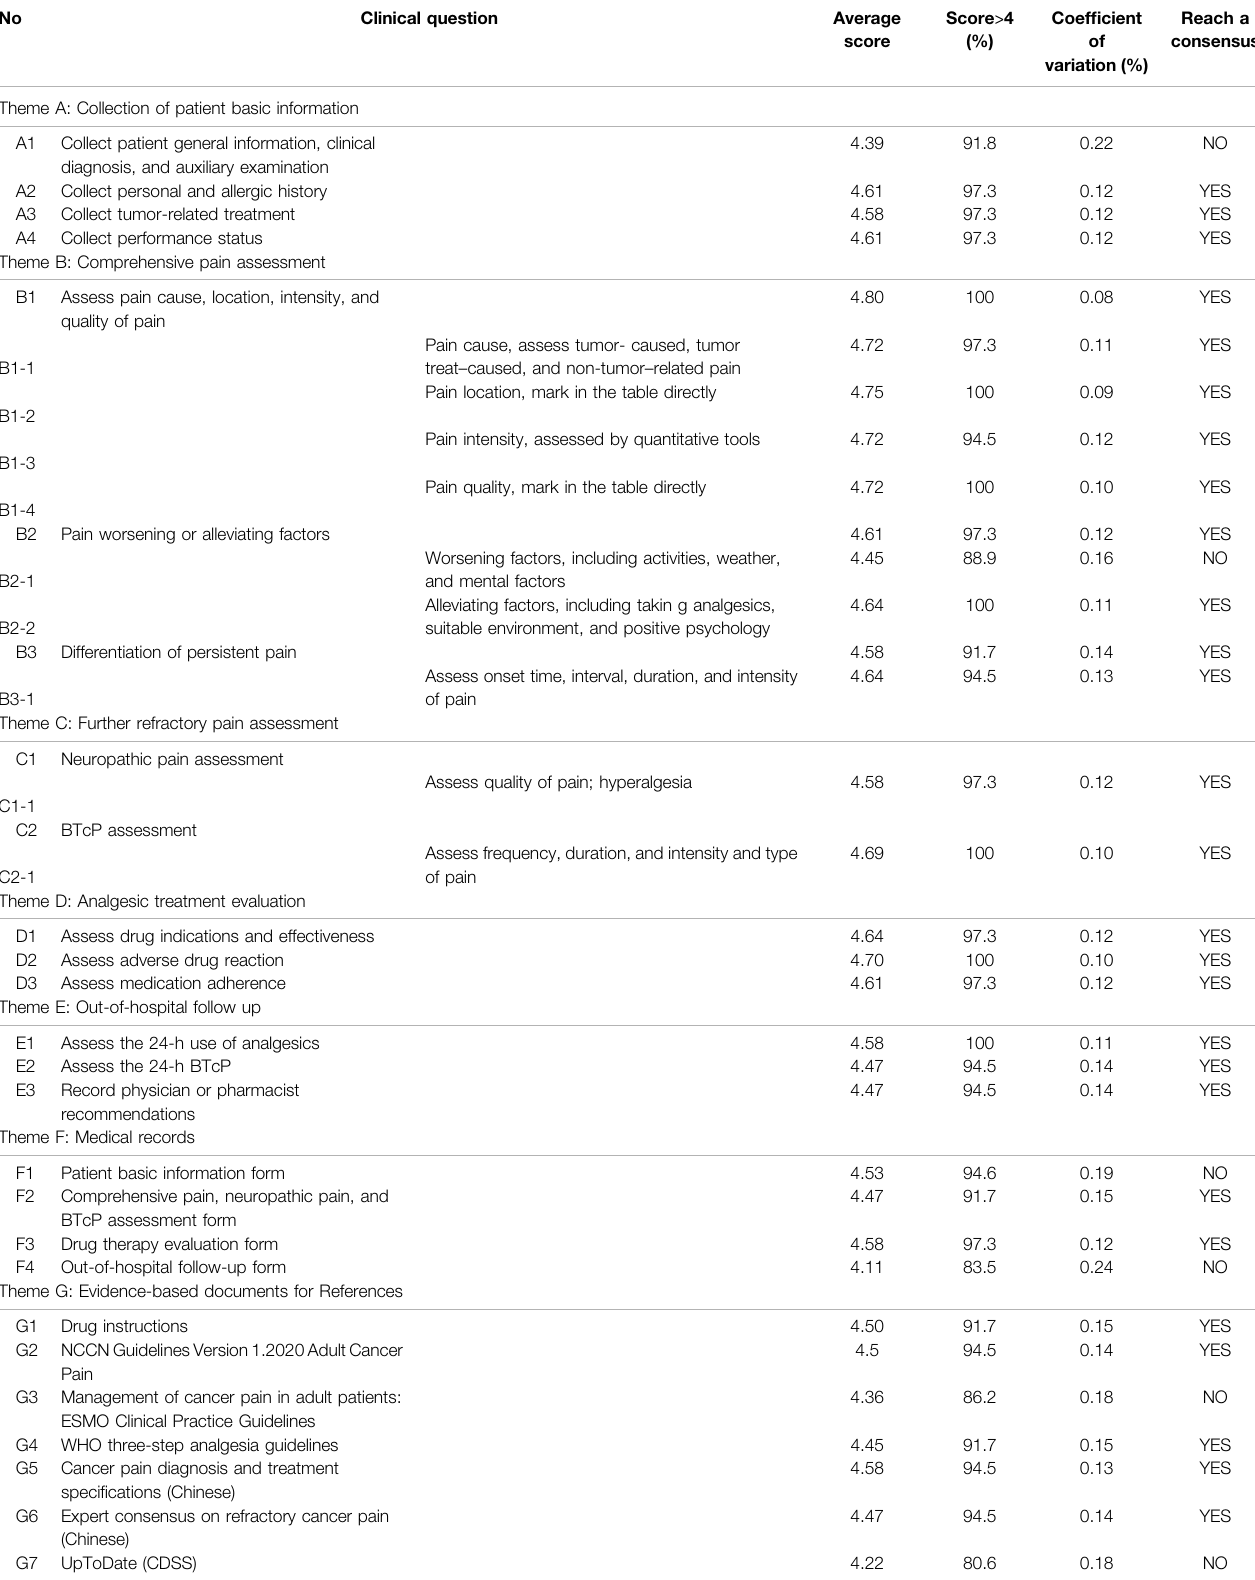
TABLE 2 | Clinical questions of the fi rst